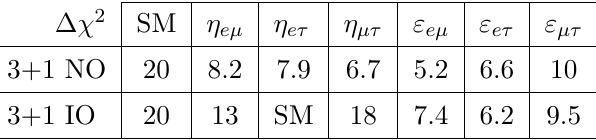
Table 5 . Same as table 3 but with true values set to the best fits of 3+1 sterile neutrino